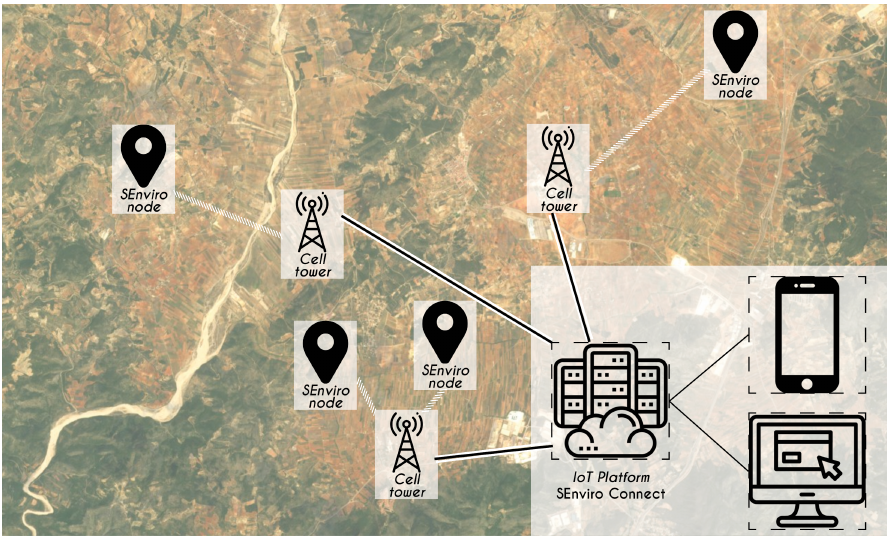
Figure 5. the wireless communication model used to connect devices to IoT